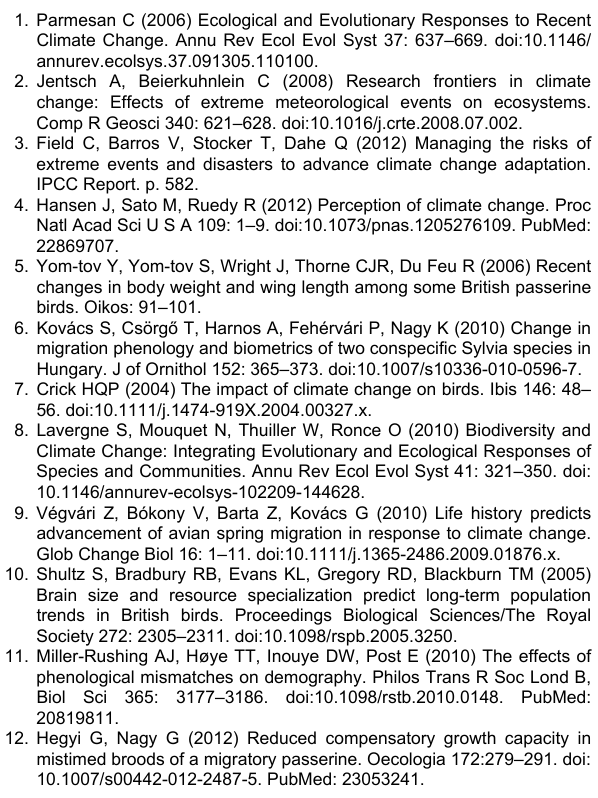
Table S2. Model set for hatching success; models with ∆AIC>2 are written in bold (n=262 nests).